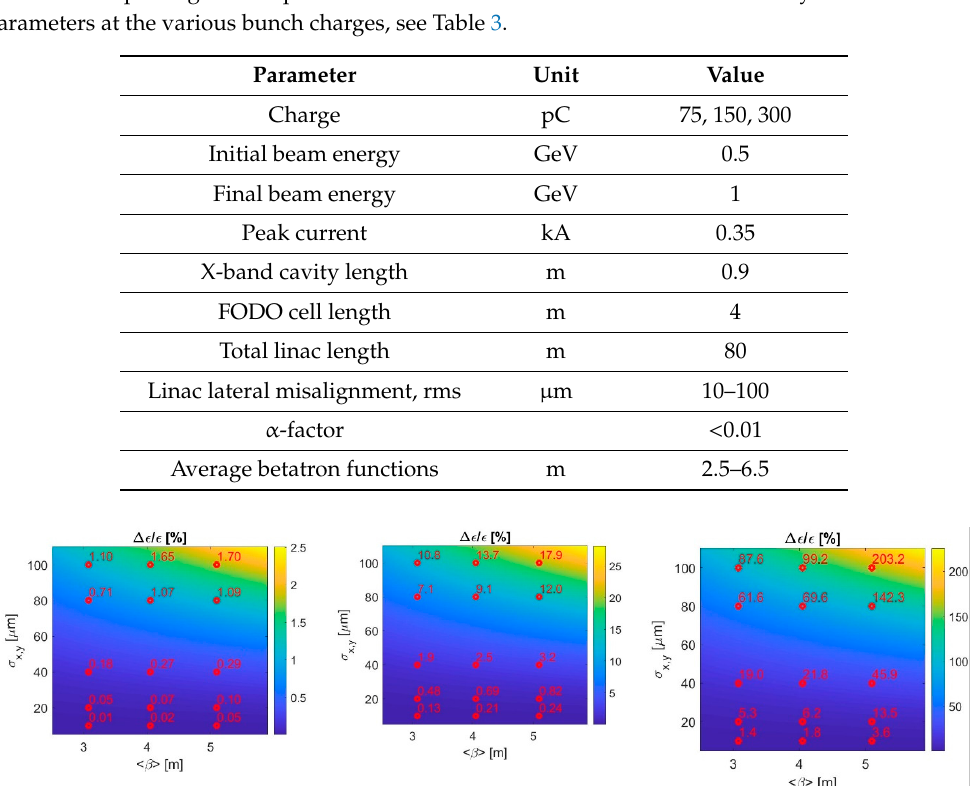
Figure 7. Projected normalized relative emittance growth due to BBU along the linac downstream BC2 vs. average betatron function, at the bunch charge of (from left to right) 75, 150, and 300 pC. In each plot, solid (dashed) lines are for 100 µm (10 µm) RMS misalignment of accelerating structures and BPMs. 5. Free-Electron Laser 5.1. Peak Brilliance In this section, the dependence of photon brilliance and pulse energy on beam emittance and bunch charge is analyzed. We will consider the SASE scheme, which is planned both in the baseline and the upgraded designs, in the following discussion. An expression for the brilliance (in practical units) which assumes uniform beam parameters along the electron bunch, and thereby slice and projected emittance to coincide, is given in [49,50]: 𝐵 (cid:3043)(cid:3035) ≅ 4.5 × 10 (cid:2871)(cid:2868) 𝐼(𝑘𝐴) × 𝐸(𝐺𝑒𝑉) 𝜆(𝑛𝑚) × 𝛿 [#photons/sec/mm2/mrad2/0.1%bw]